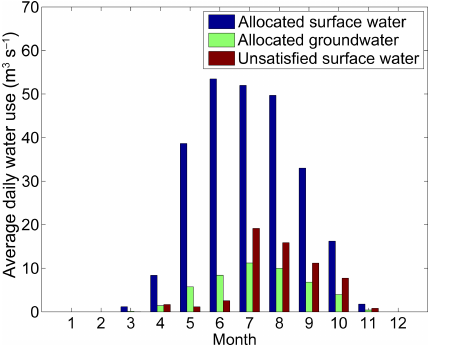
Figure 10. Average daily allocated surface water, groundwater, and unsatisfied surface water use for each month from 2006 to 2013.